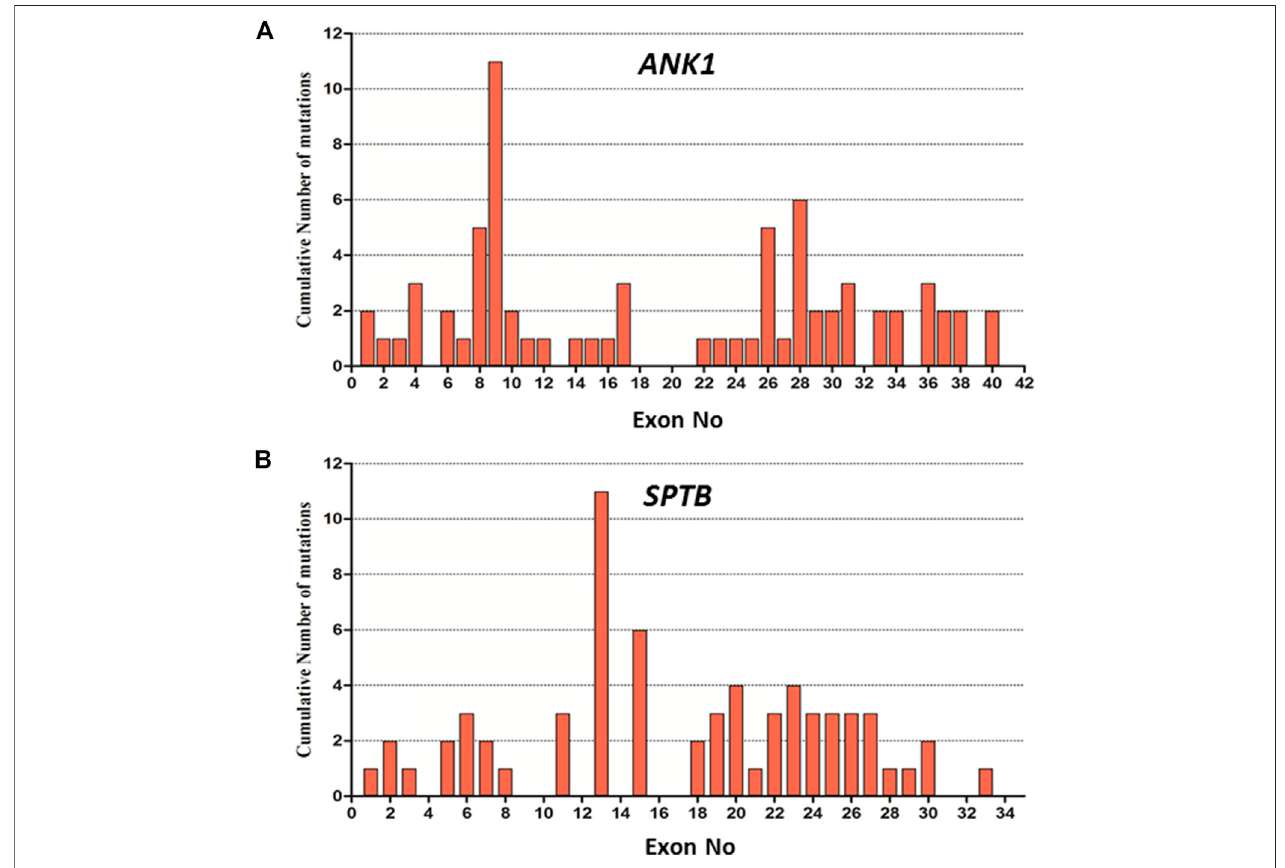
FIGURE 2 | Distribution of mutations in the exon of ANK1 and SPTB gene. (A) Cumulative Number of mutations in each exon of the ANK1 gene. (B) Cumulative Number of mutations in each exon of SPTB gene.